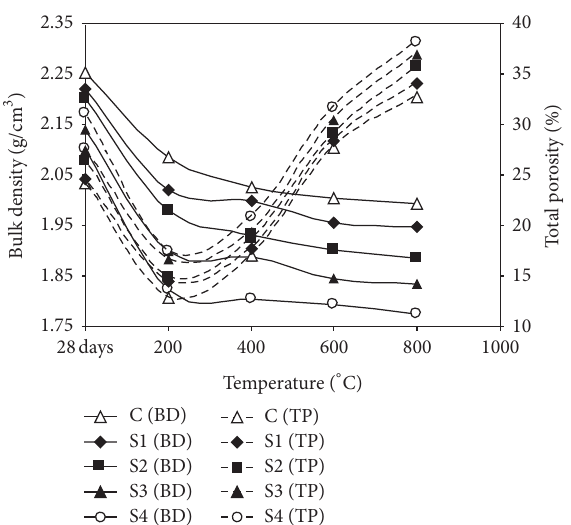
F 9: e bulk density and total porosity of sewage sludge ash blended cement pastes �red at 200–800